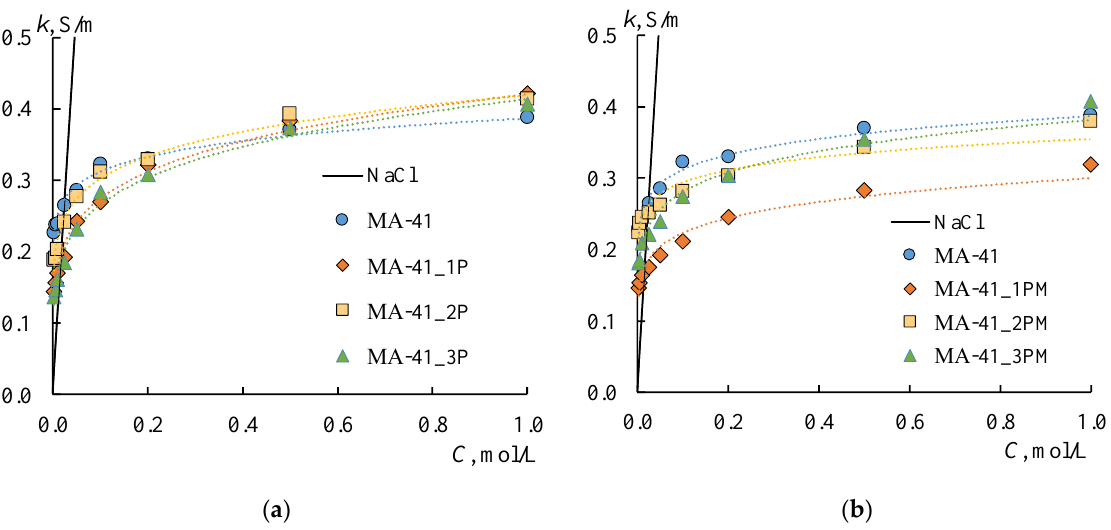
Figure 11. Concentration dependences of conductivity for initial, profiled ( a ), and bilayer profiled ( b ) MA-41 membranes in NaCl solutions.